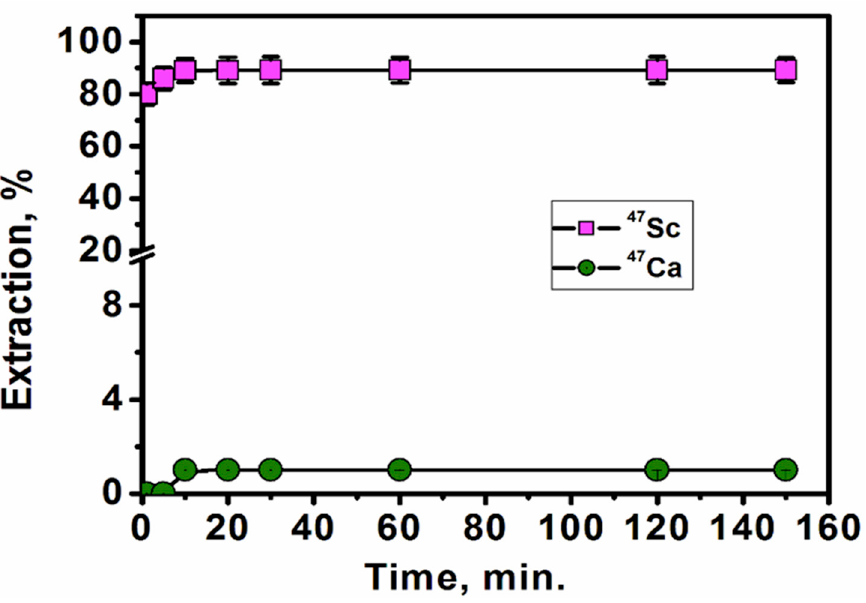
Figure 5. Effect of contact time on the extraction of 47 Sc and 47 Ca at a 1:1 phase ratio, with 0.025 M Cyanex 272, at pH 1.8 and 25 ± 1 °C.